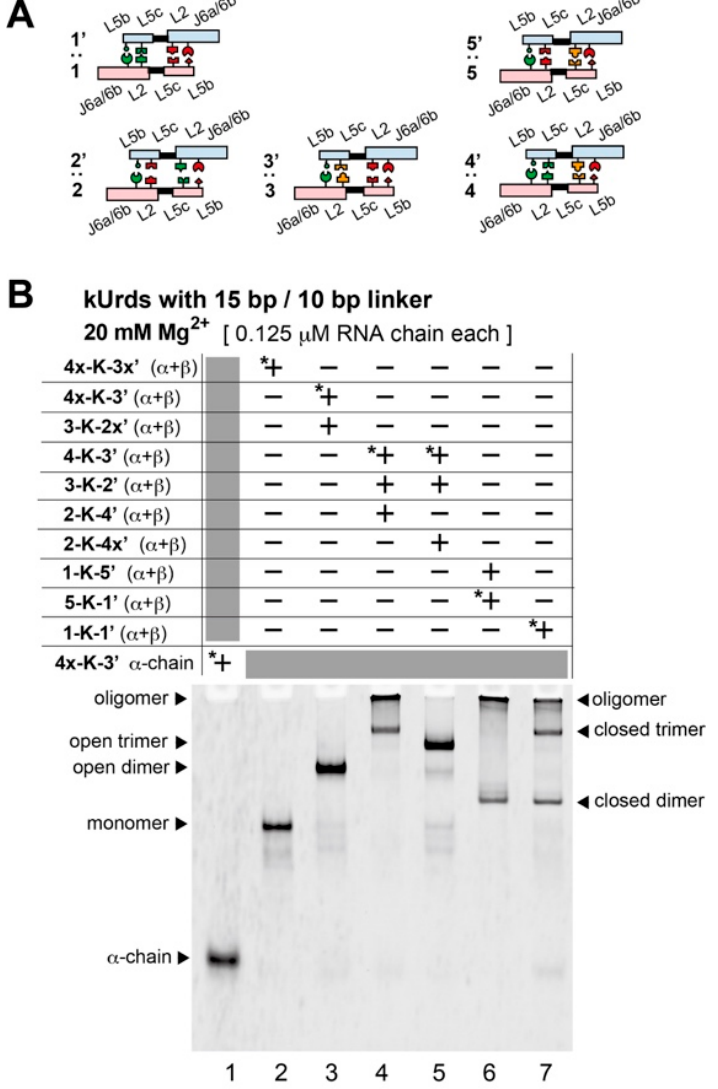
Figure 3. Assembly of a trio of kUrds to form a closed heterotrimer and a pair of kUrds to form a closed heterodimer. ( A ) Five distinct pairs of RzM:RzM interfaces, three of which were used in a closed heterotrimer configuration and the remaining two of which were used in a closed heterodimer configuration. Sequences and secondary structures of RNA motifs specifying RzM:RzM interfaces are shown in Figure S3. ( B ) EMSA of triblock and diblock kUrd copolymers formed in the presence of 20 mM Mg 2+ . Asterisks indicate RNA chains labeled with BODIPY fluorophore. The pair of kUrds for diblock copolymer also formed oligomers with no migration (lane 6 in Figure 3B). This mixture also yielded a band the mobility of which corresponded to the possible closed dimer of 1-K-1 ′ (lanes 6 and 7 in Figure 3B). No band was seen in lane 6 at the position corresponding to that of the possible closed trimer. In the closed heterotrimer consisting of three distinct kUrds, each kUrd was formed by α - and β -chain RNAs. As the kUrd closed heterotrimer contained six distinct RNA chains, we labeled one of six RNA chains with BODIPY fluorophore and monitored the mobility of the closed trimer on native gels (Figure S6). Regardless of the identity of the BODIPY-labeled RNA chain, all EMSA showed similar behavior, supporting the formation of the closed hetero- trimer by assembly of three kUrds. 3.4. Atomic Force Microscopy Analysis of kUrd Heterotrimer and Heterodimer Based on the observation that three kUrds are likely to form closed trimers in both homopolymerization and triblock copolymerization, we visualized the molecular struc- tures of the heterotrimer ( 3-K-2 ′ :2-K-4 ′ :4-K-3 ′ ) and heterodimer ( 1-K-5 ′ :5-K-1 ′ ) by atomic force microscopy (AFM) [33,37–39]. In the presence of 17.5 mM Mg 2+ , a sample containing three kUrds gave AFM images containing objects with triangular shapes (Figure 4A,B). The triangular objects were observed with limited frequency. We measured lengths of 21 sides of seven triangular objects observed in AFM images. While their lengths varied be- tween 28.1 nm 39.6 nm, their average value was 34.5 nm. This value was closely similar to that predicted by molecular modeling of the closed trimer (approximately 34 nm, Figure 1). In some of the AFM images of kUrd triangles, we observed triangular shapes as three bright regions (Figure 4B), heights of which were 6~8 nm (Figure S7A).